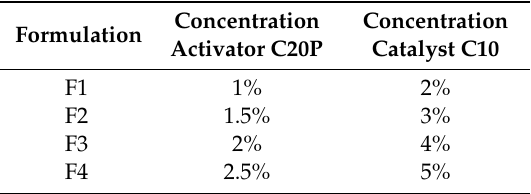
Table 2. Formulations used for the experiments with di ff erent concentrations of activator and catalyst (percentage by weight).